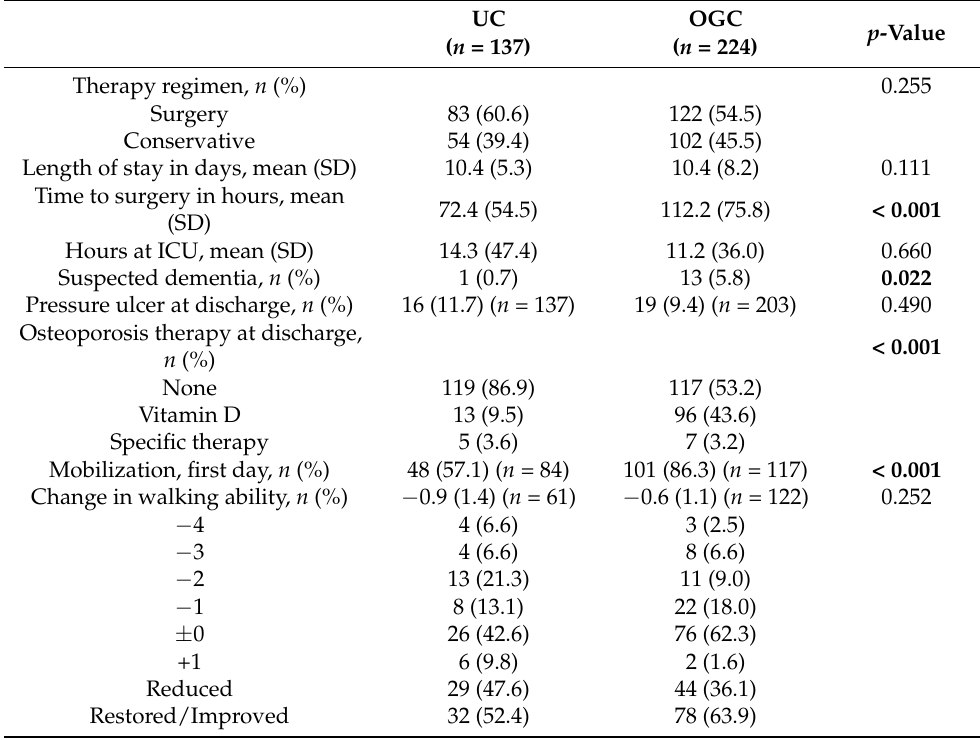
Table 4. Secondary outcome